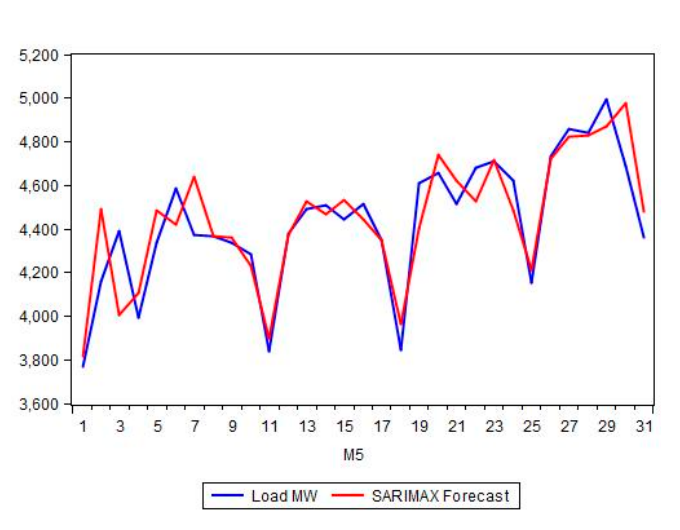
Figure 15. SARIMAX forecasts for May 2014.